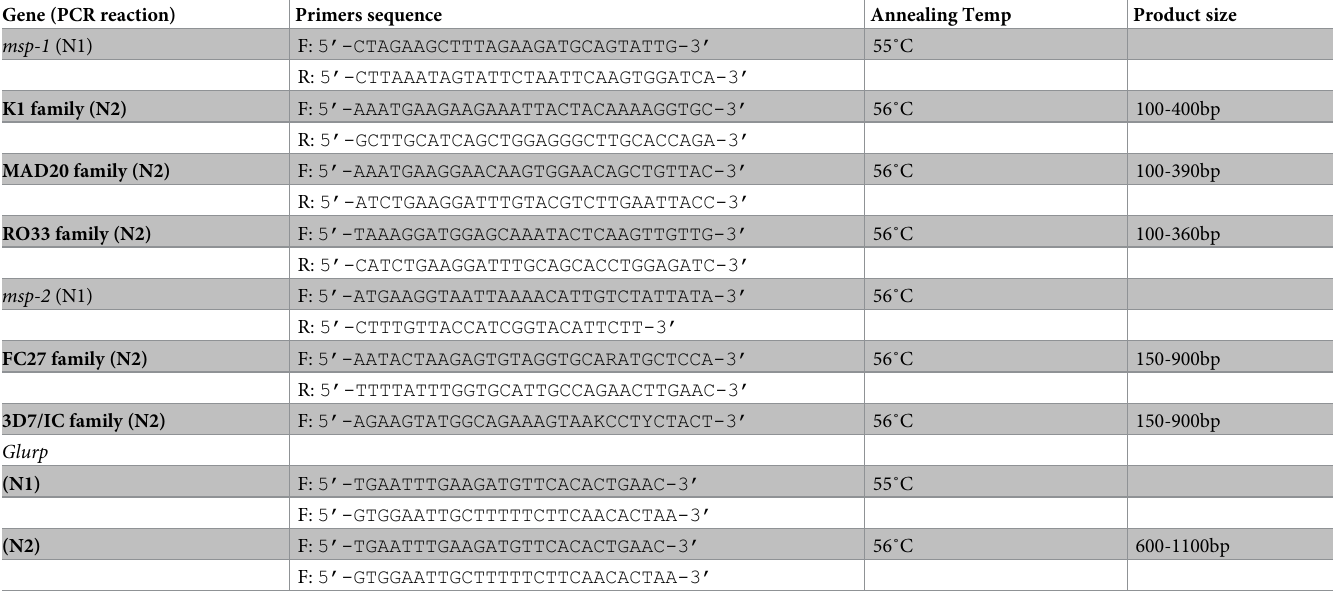
Table 1. Basic information of the primers used to amplify msp-1 , msp-2 and glurp genes of P . falciparum isolates from Khyber Pakhtunkhwa, Pakistan. Gene (PCR